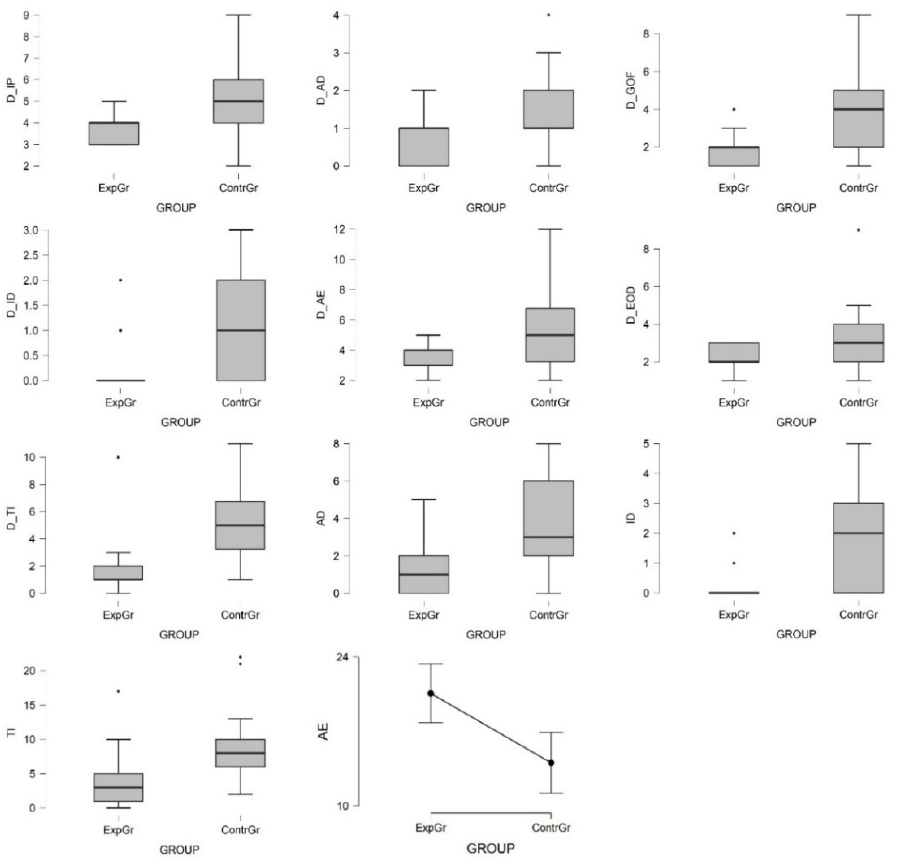
Figure 8. Boxplots for nonparametric data and descriptive plot for parametric data showing signif- icant differences between both groups regarding the use of certain linguistic aspects. Concerning the correct language use (Figure 9), the Mann–Whitney test indicated that the number of incorrect words (IW) and the diversity of incorrect words (D_IW) was significantly higher for the ExpGr than for the